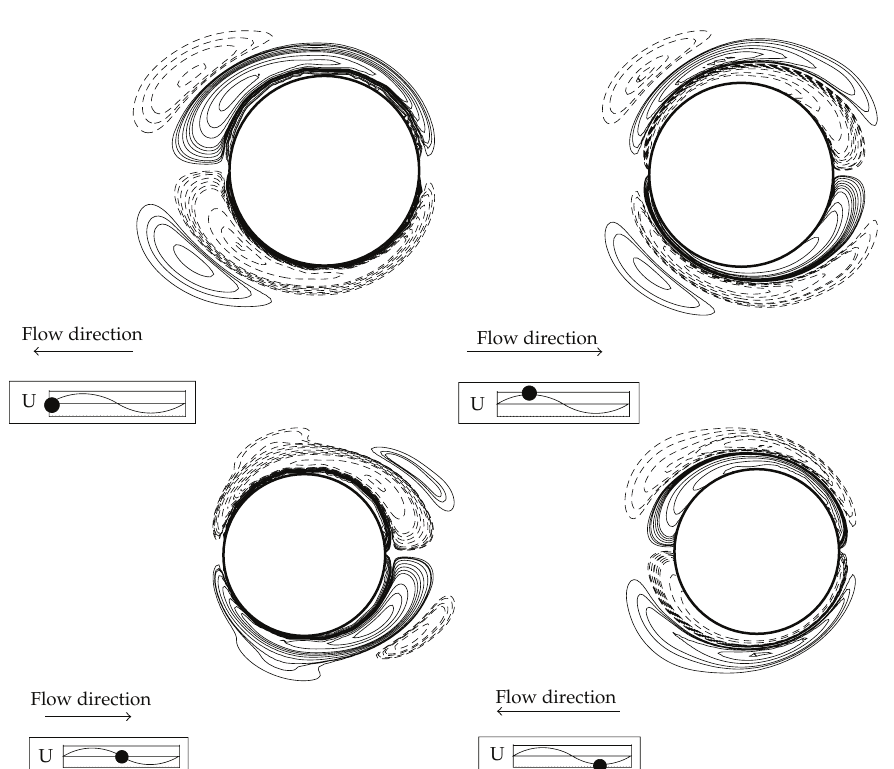
Figure 2: Evolution of vorticity distribution at KC (cid:8) 2 and Re (cid:8) 200. Dash lines refer to the negative vorticity